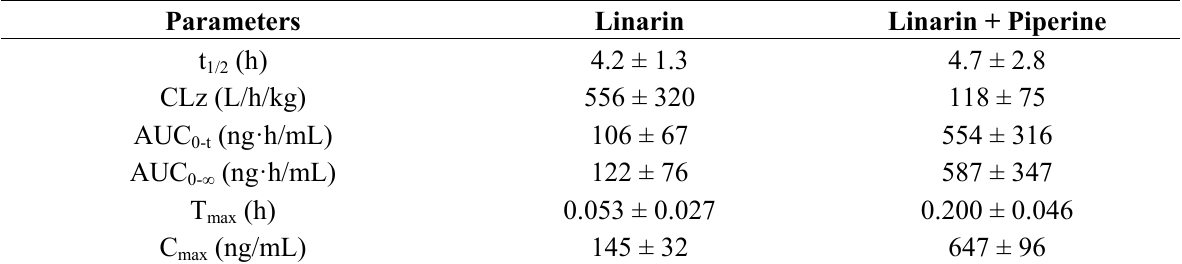
Table 2. Pharmacokinetic parameters of linarin following oral administration of